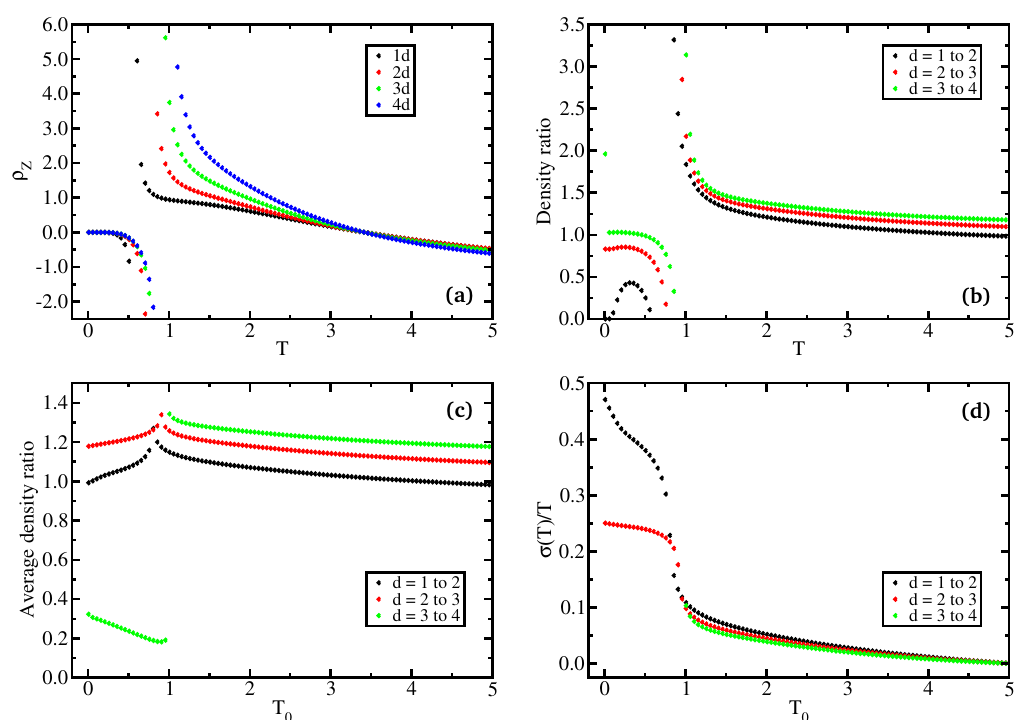
Figure 8: Density scaling between similar liquid regimes in different dimensions d = 1 to 4. For low enough densities there is a liquid-gas phase coexistence be- low T (cid:39) 1.7 for d = 4 (for lower dimensions this temperature gets slightly lowered).